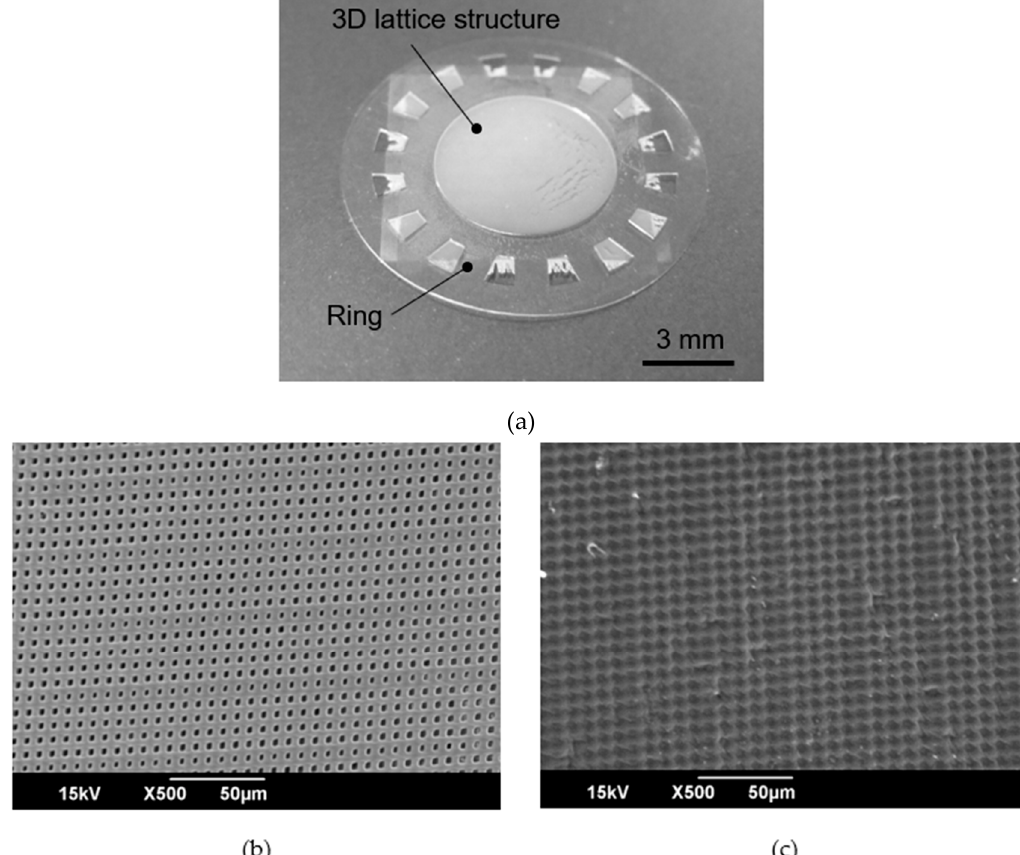
Figure 6. Images of the fabricated cell culture plate. The fabricated cell culture plate had the 3D lattice structure which was the rough surface. The pore, which was not penetrated, on the 3D lattice structure was smaller than the designed size. ( a ) The fabricated cell culture plate having 3D lattice structure. ( b ) SEM image of the 3D lattice structure on the side that was in contact with the Cr pattern on the glass substrate (Top side). ( c ) SEM image of the 3D lattice structure on the side that was not in contact with the Cr pattern on the glass substrate (Back side).